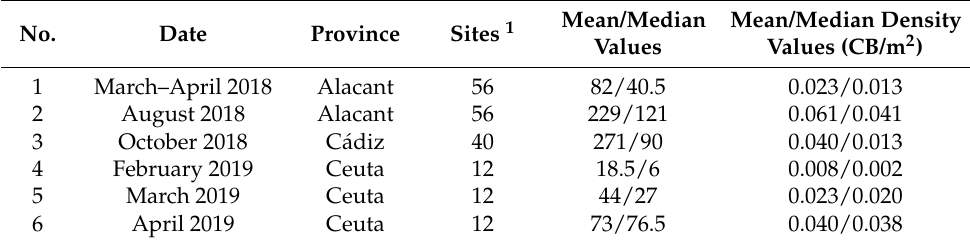
Table 1. Number of sites according to each research and data of cigarette butts (CB).